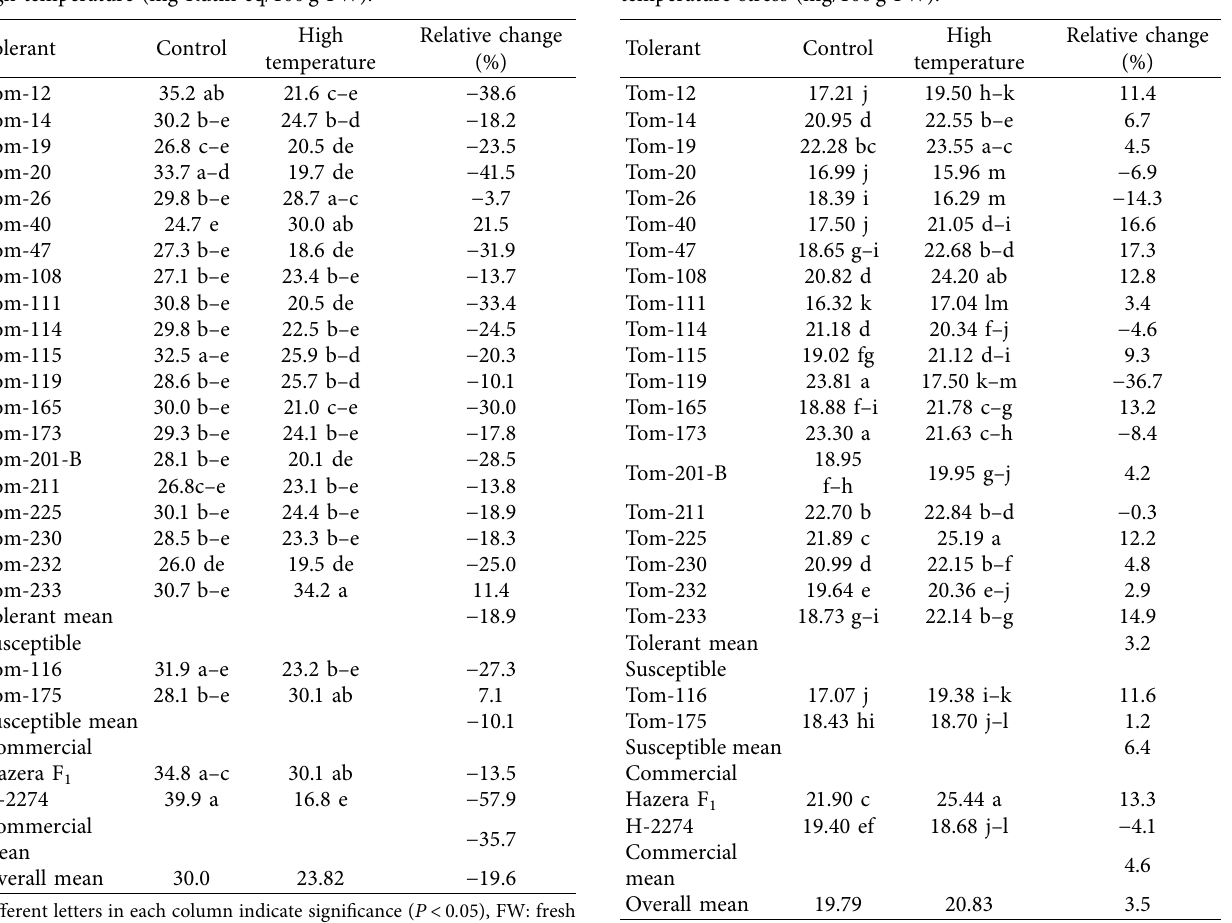
Table 8: Total flavonoids of tomato fruits grown under control and high temperature (mg Rutin eq/100g FW).